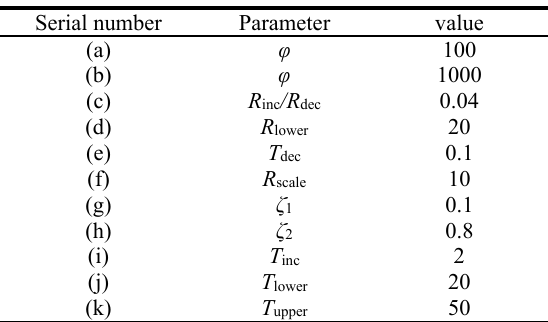
Table 2 Parameters setting in our